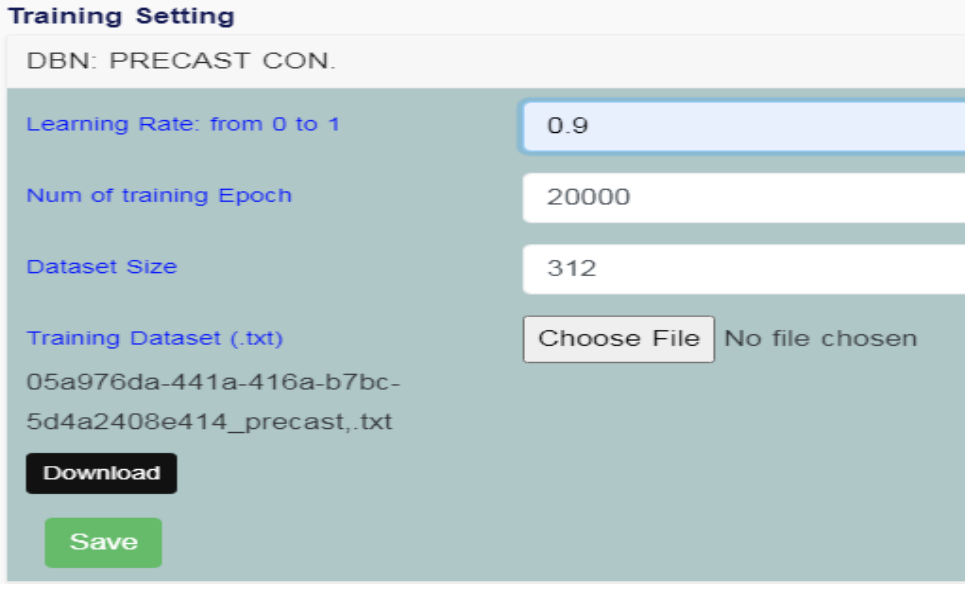
Figure 3. Setting the required parameters for the training operation code. Step 3: loading the training